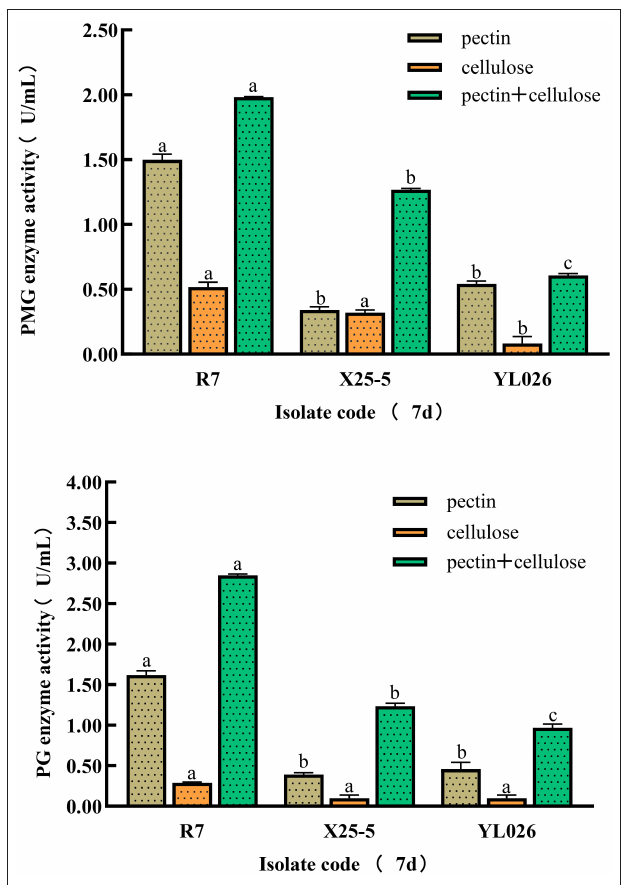
FIGURE 6 | Carboxymethyl (Cx) and β -glucosidase activities in different kinds of ginseng RRR pathogen. Different letters in each column indicate statistically significant differences at the 0.05 probability level according to the Duncan test. a,b,c indicates the statistical difference without any specific